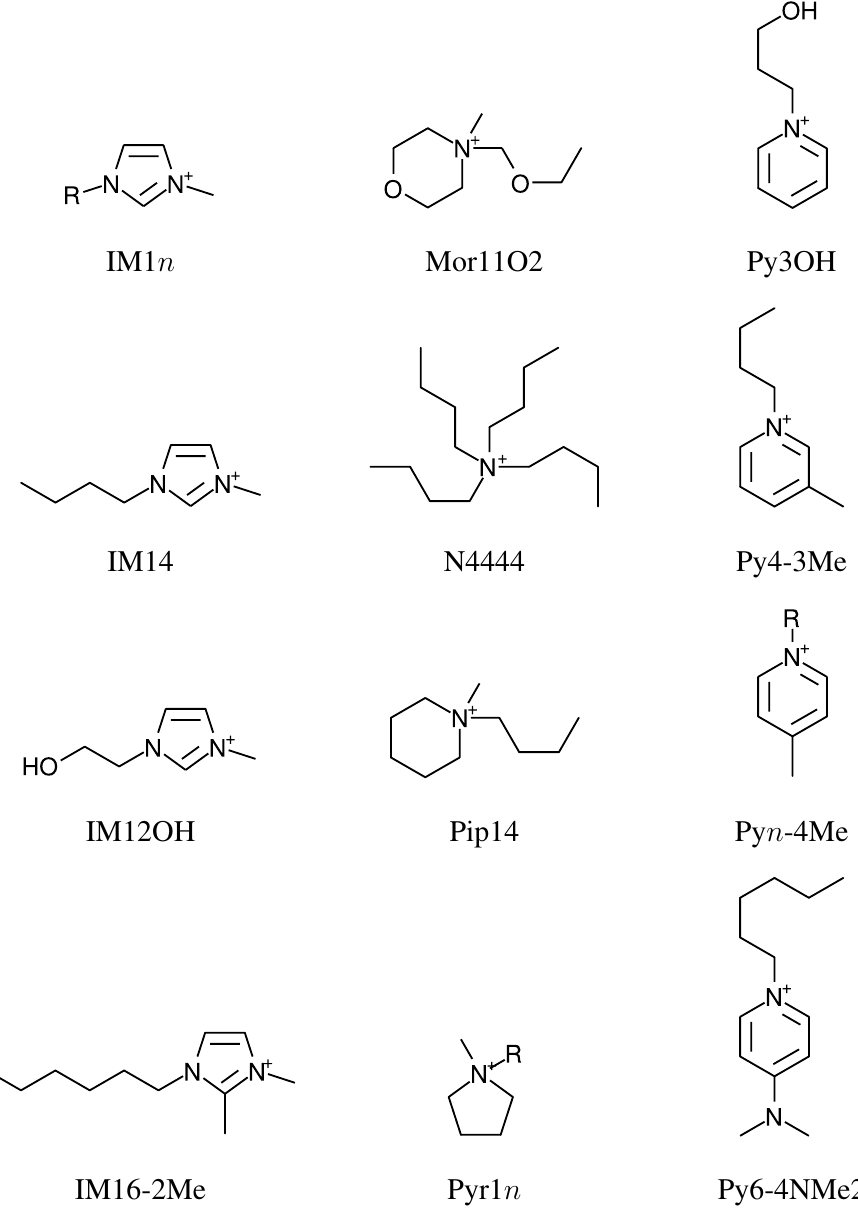
Table 1. Chemical structures of the cations treated in this study, along with their acronyms. In the acronyms, IM, Mor, N, Pip, Pyr and Py are used for the imidazolium, morpholinium, ammonium, piperidinium, pyrrolidinium and pyridinium head groups. n designates linear alkyl chains with varying length, where n is the number of carbon atoms in the chain. In the graphs, these chains correspond to the residues